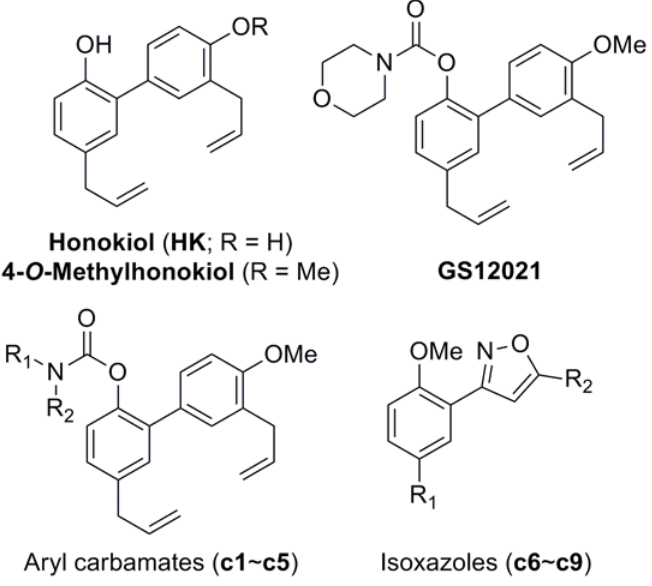
Fig 1. Chemical structures of honokiol, 4- O -methylhonokiol, and their derivatives.